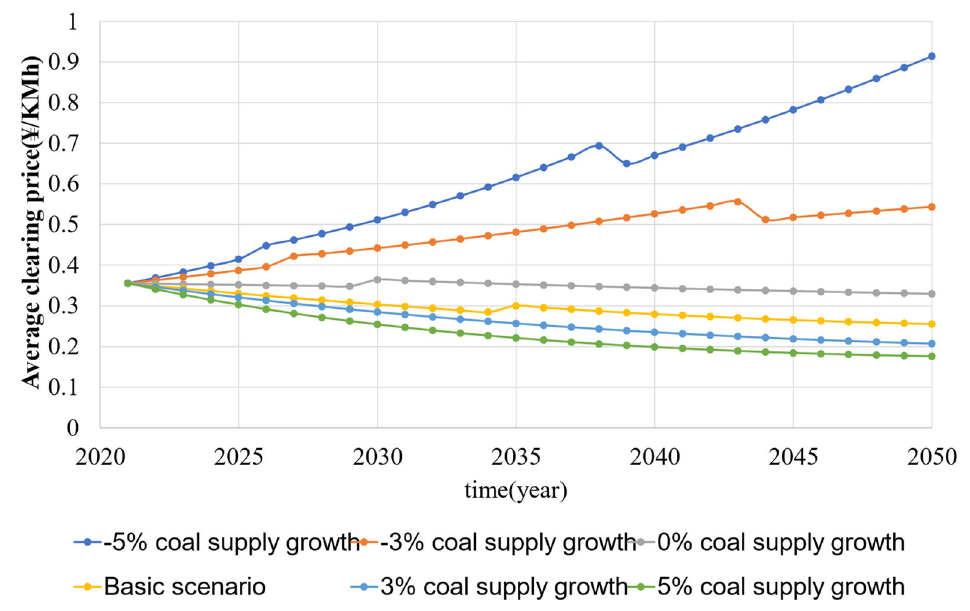
Figure 11. Change in average clearing price based on coal supply growth rate.